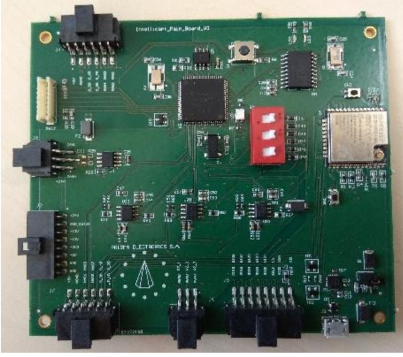
Figure 3. The RMC